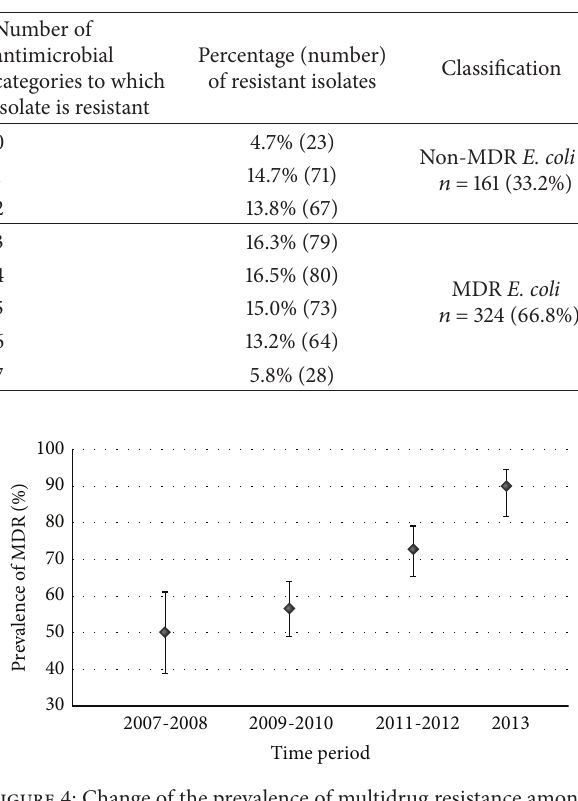
Table 2: Analysis of multidrug resistance among E. coli isolates ( 𝑛 = 485 ).